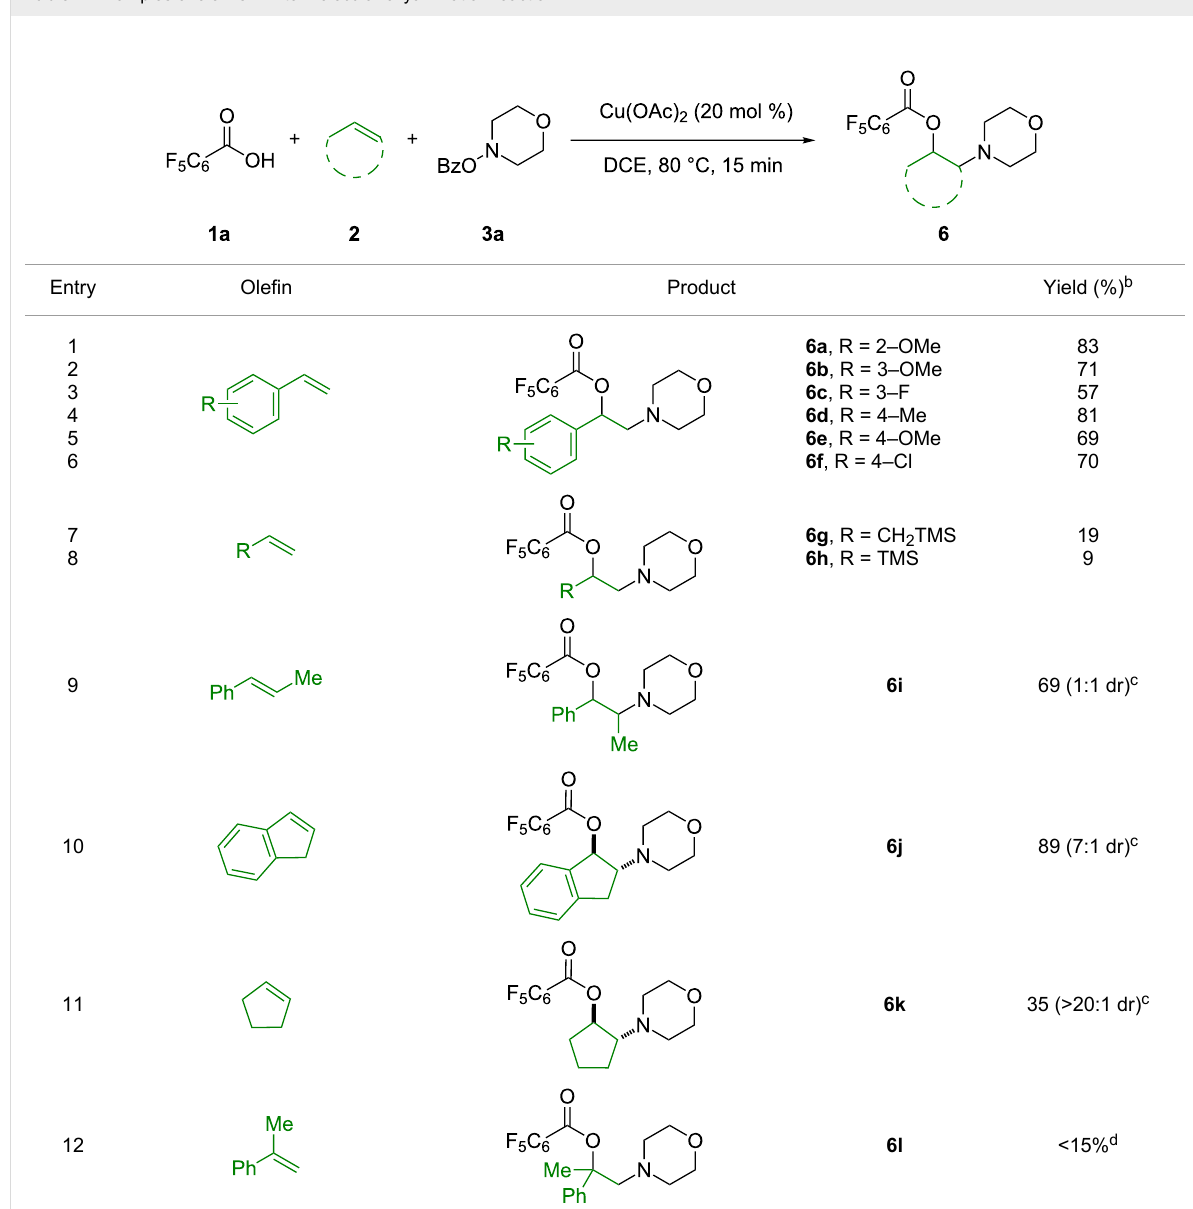
Table 2: Examples of olefins in intermolecular oxyamination reaction.